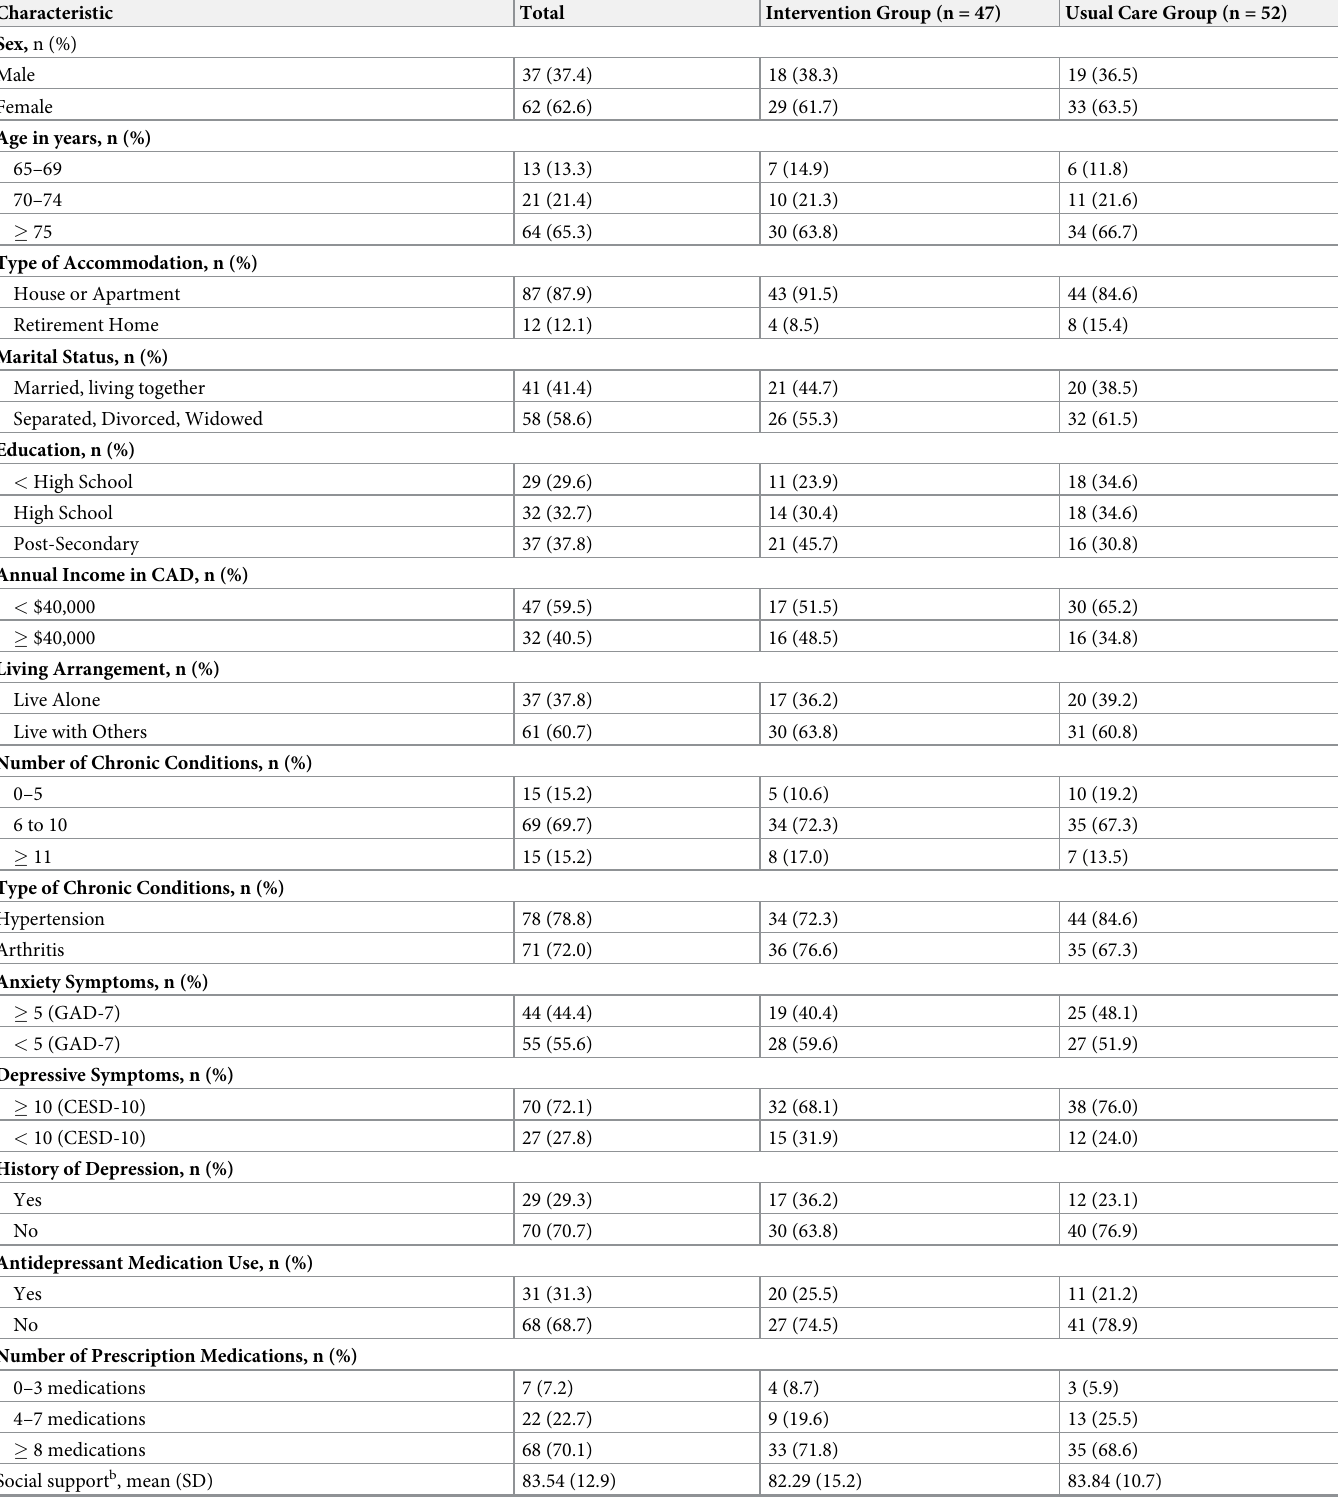
Table 2. Baseline characteristics of older adults with multimorbidity and depressive symptoms (n = 99) a